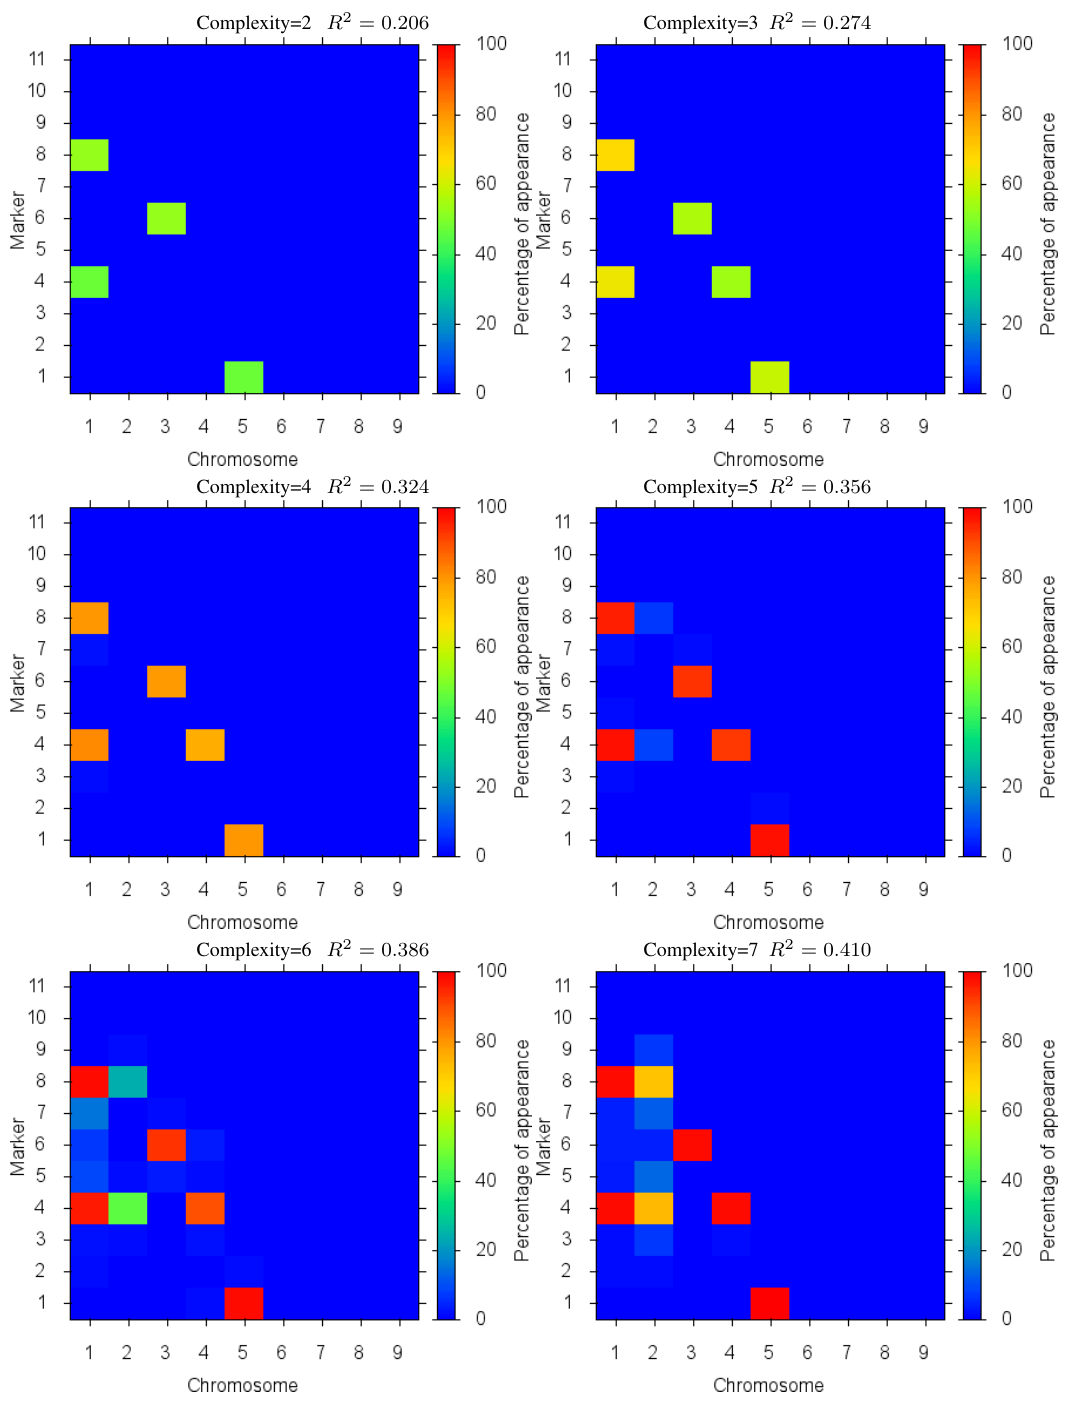
Figure 4. Case I Identified Markers: Identified markers found in different complexity Pareto optimal solutions for Case I. The color is the proportion of random executions that the specific marker was found. Bright red signifies that in each run the marker was consistently found. Blue means that the marker did not appear in any